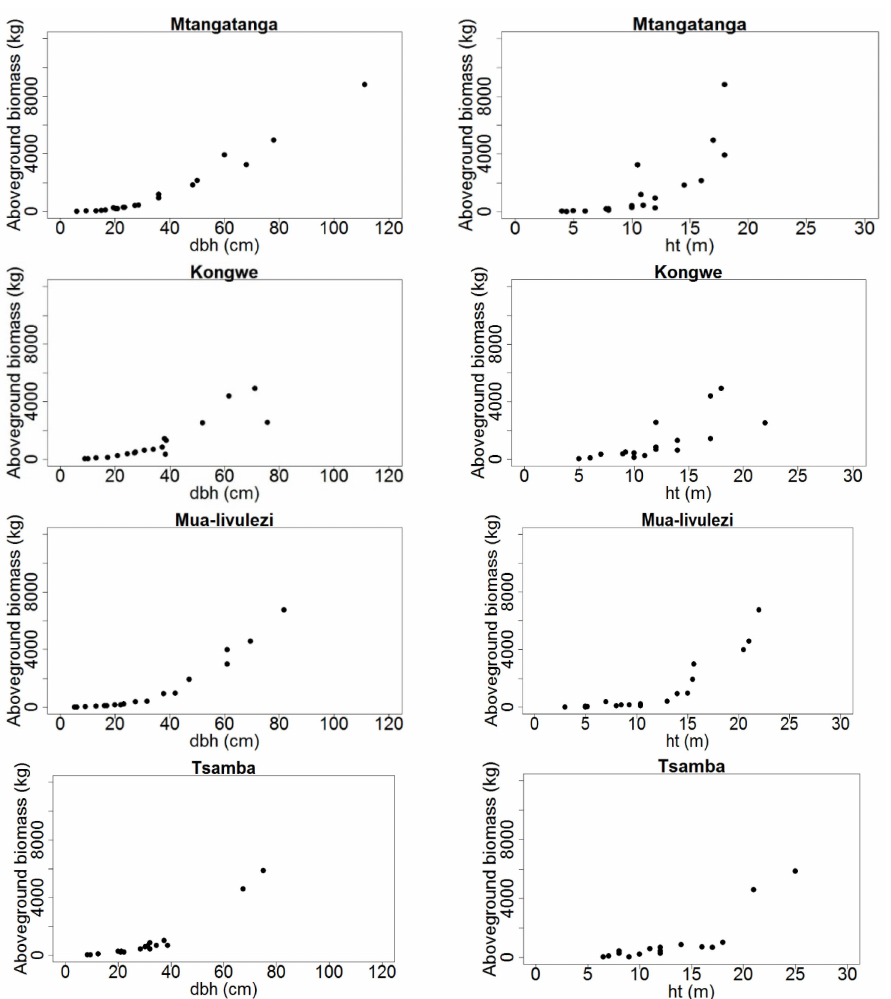
Figure 2. Total aboveground tree biomass (kg dry weight) distribution over dbh (cm) and ht (m) for Mtangatanga, Kongwe, Mua-livulezi and Tsamba and forest